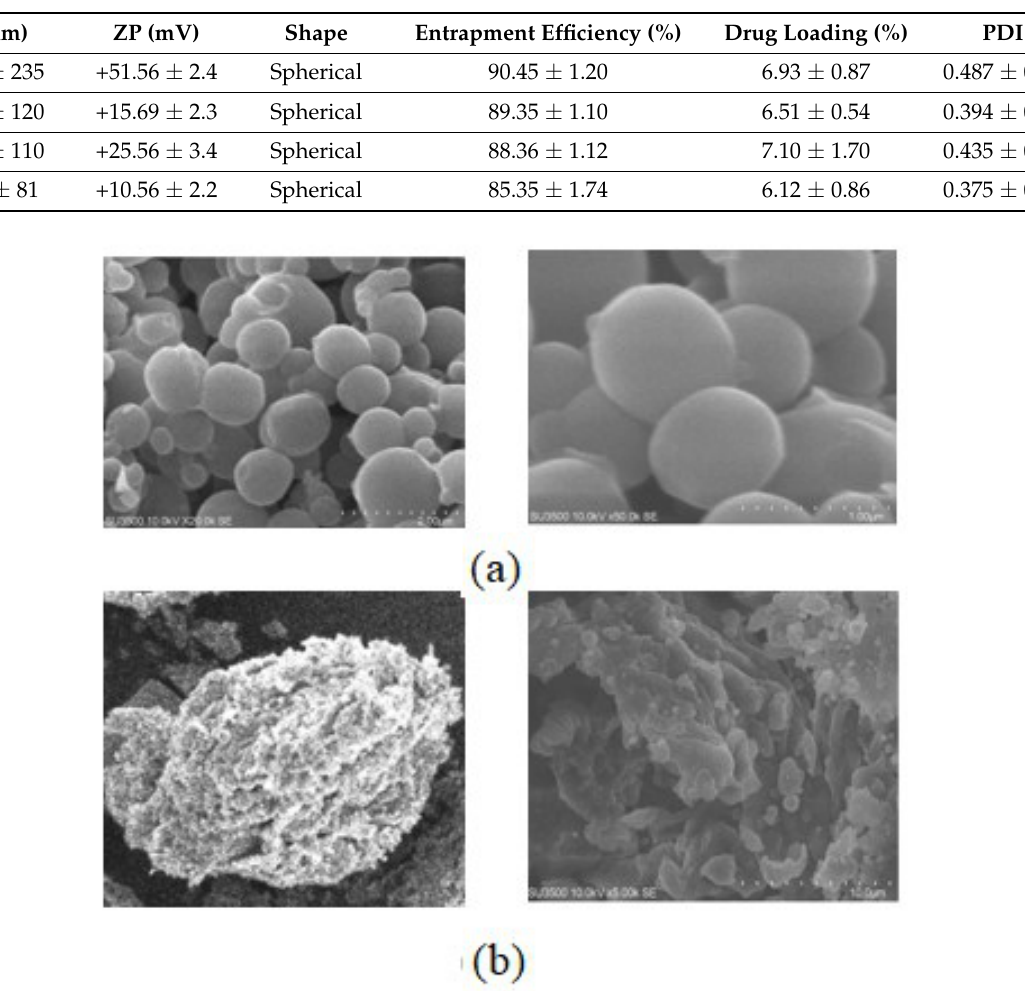
Table 4. The mean EE and DL of the NPs.